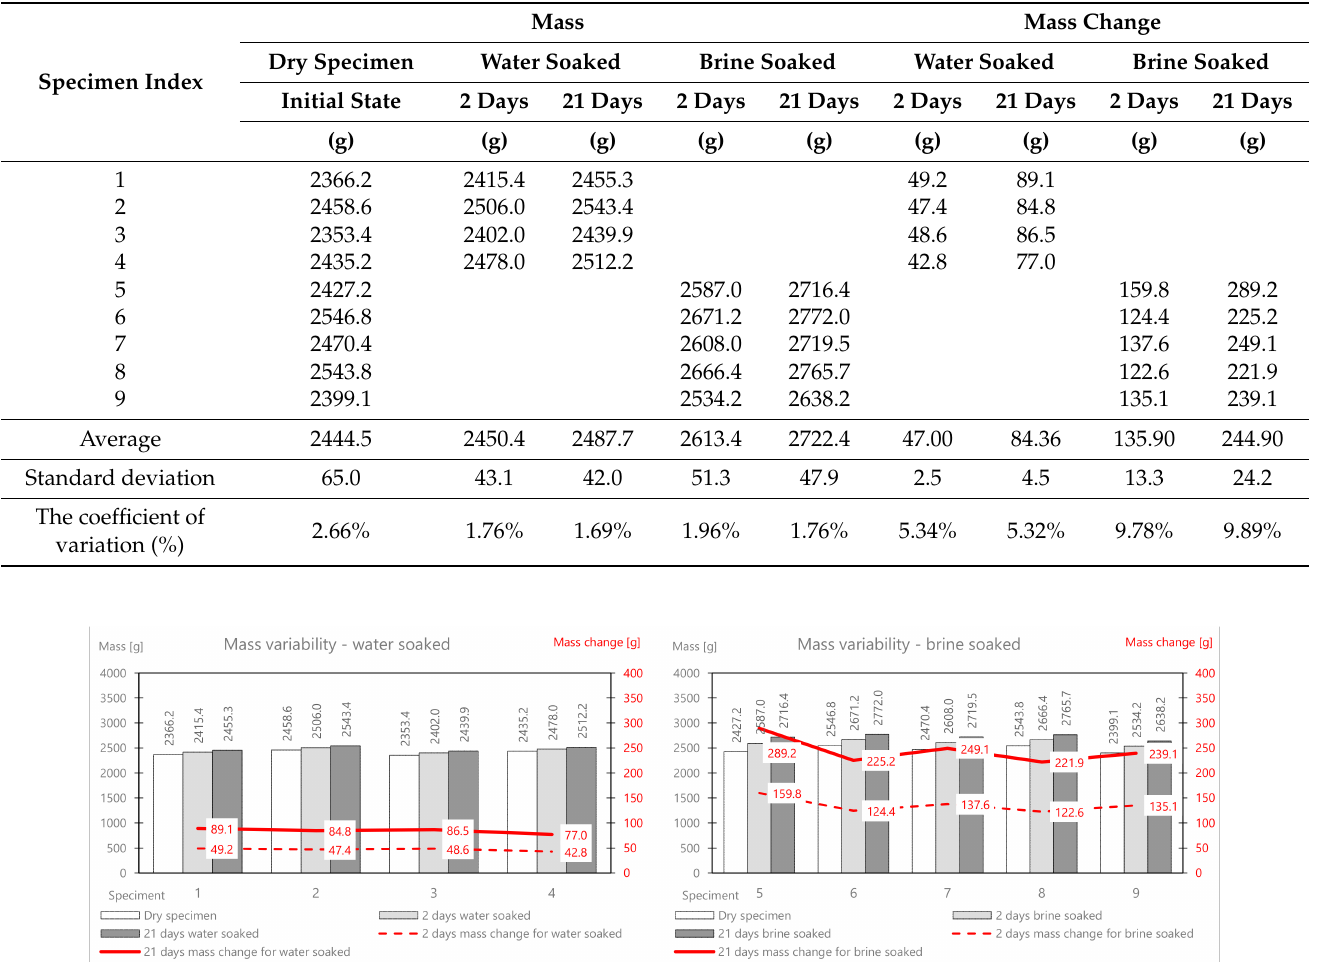
Figure 11. MCAS mix mass